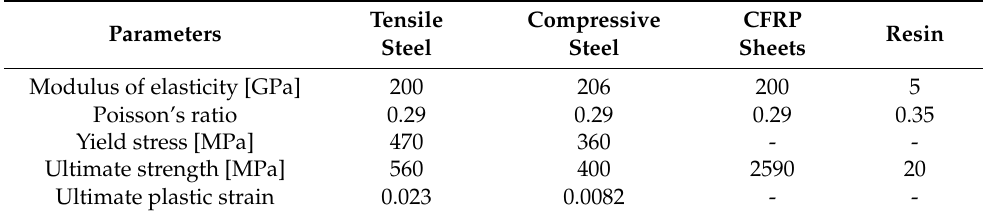
Table 1. Properties of material used in FE modeling of tested